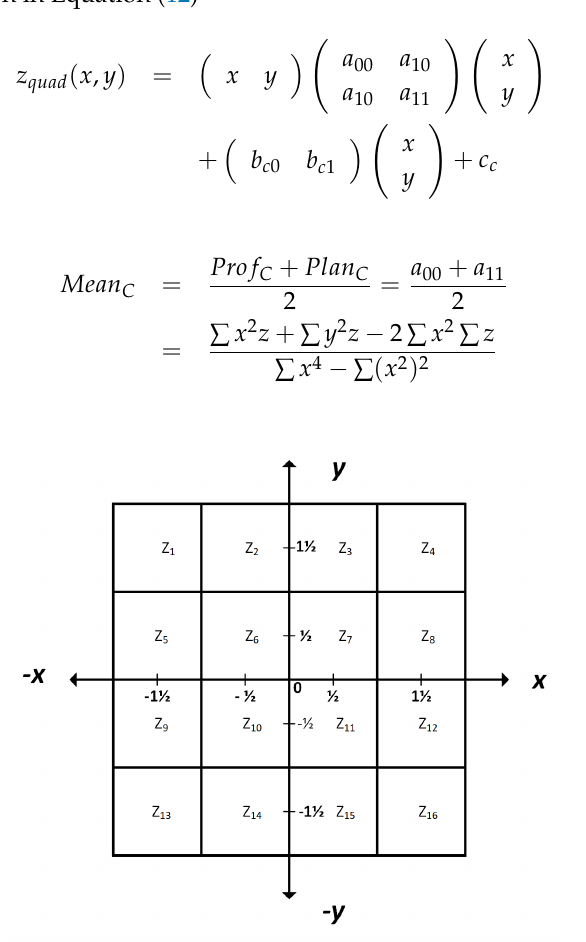
Figure 4. Aggregation results of x , y and xy is zero due to